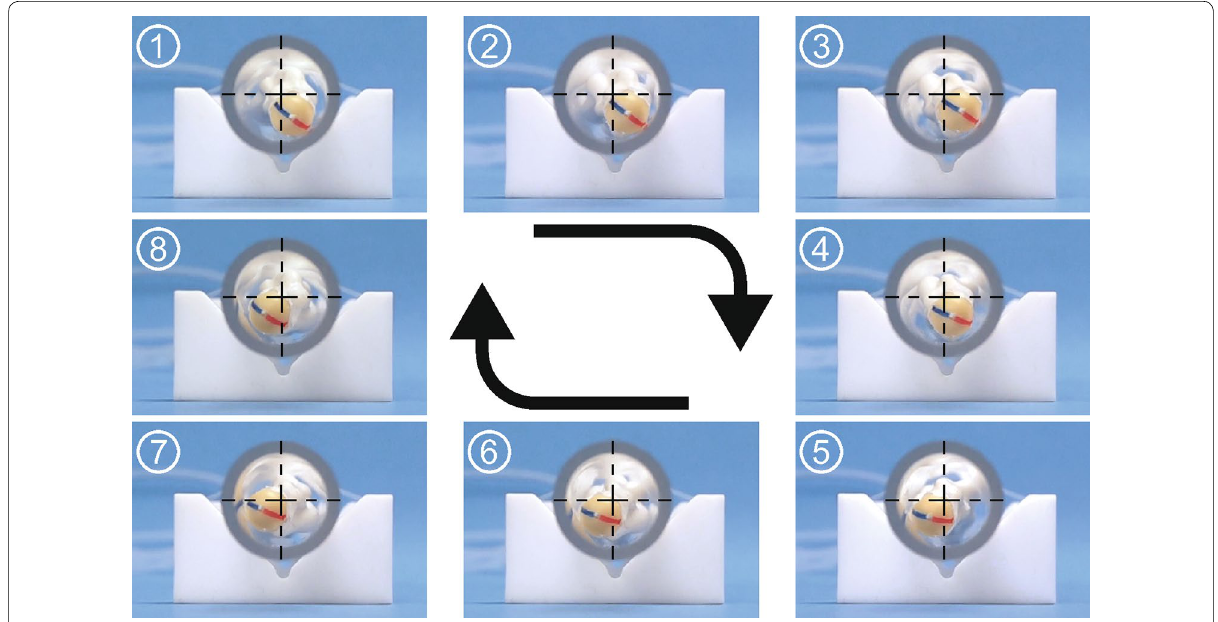
Fig. 13 Progression of Prototype 1 tip motion. The tip remains in the bottom-half of the